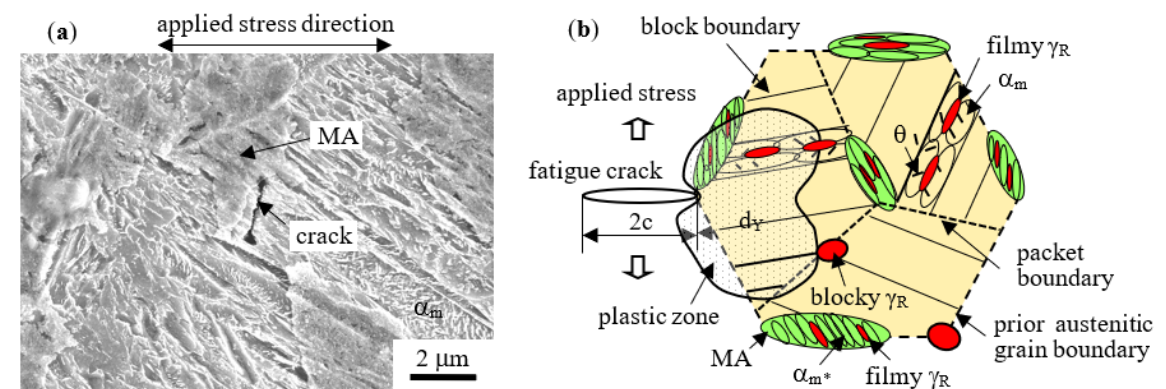
Figure 13. ( a ) SEM image of the initial crack formed on the notched surface of 0.4%C–1.5%Si–1.5%Mn TM steel (DQ-P, T p = 250 ◦ C) failure at N f = 5.0 × 10 4 cycles [75]. ( b ) Illustration of the plastic zone size ( d Y ) at the crack tip and distribution of MA phases in the TM steel [75]. α m , α m *, γ R , and θ represent coarse lath-martensite and fine lath/twin-martensite in the MA phase, retained austenite and carbide, respectively. Reprinted with permission from ISIJ: ISIJ Int, Copyright 2021.